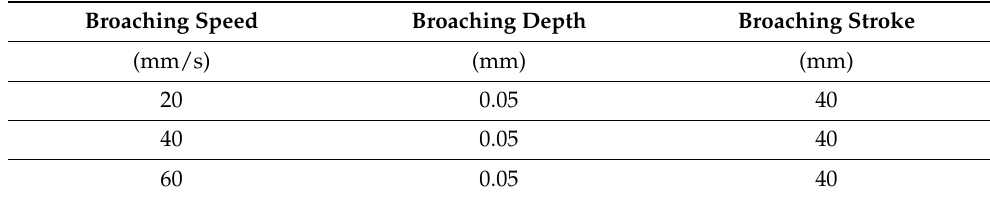
Figure 3. Broaching test site layout. Table 6. Parameters of the broaching experiment.